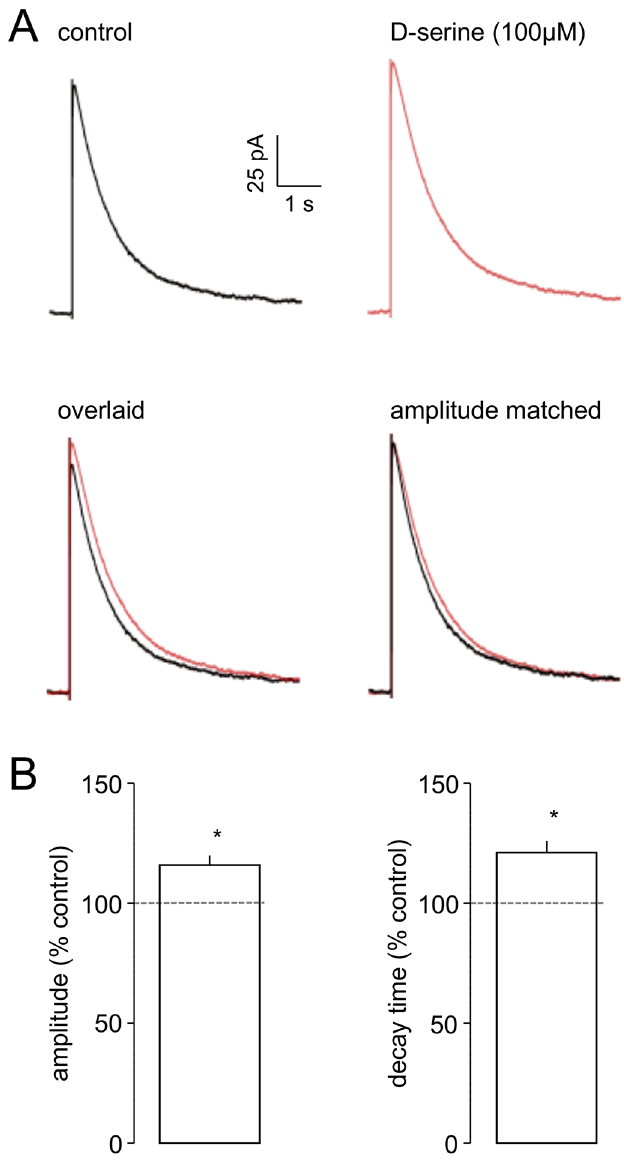
Fig 3. D-serine increases the amplitude and decay time of eNEPSC in EC neurones. A. The traces show averaged eNEPSCs recorded in one neurone. A small, but clear, increase in amplitude by D-serine can be seen when the responses are overlaid. When control and D-serine responses were scaled to the same amplitude and overlaid, the prolongation of decay time is also apparent. B. The histograms show pooled normalised data for eNEPSC amplitude and decay times in the presence of D-serine in six neurones. * P <